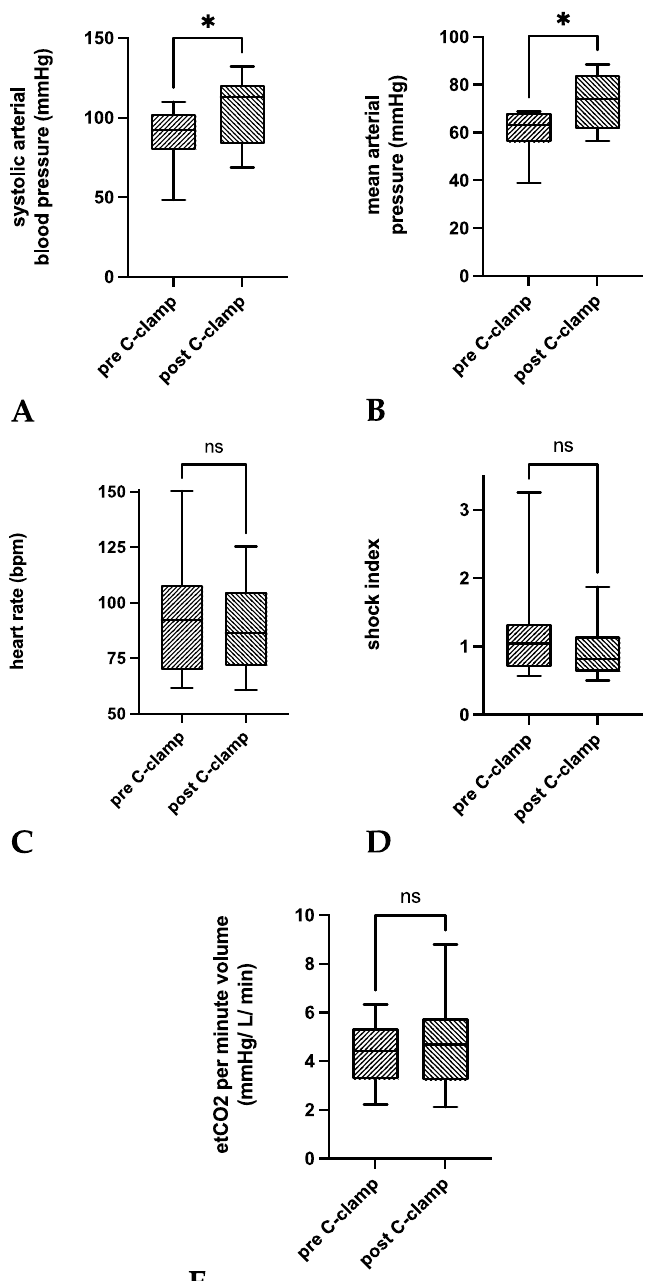
Figure 2. Box plots of the pairwise comparisons of means 30 min before (pre C-clamp) and after (after C-clamp) C-clamp application for ( A ) sABP, ( B ) MAP, ( C ) heart rate, ( D ) shock index, and ( E ) etCO 2 per minute volume. Paired comparisons of respective means revealed a significant mean increase of sABP (+14.9 mmHg; 95% CI 1.9–28; p = 0.0284) and MAP (+12.1 mmHg; 95% CI 2.1–23.5; p = 0.0157) after C-clamp application. Mean HR, SI, and etCO 2 per minute volume did not significantly differ before and after C-clamp application. Box—interquartile range; bar—median. * p < 0.05. A shorter time to C-clamp application was associated with a greater increase in the mean sABP ( p = 0.0253, r = -0.6149; Figure 3A), a greater decrease in HR ( p = 0.027, r = 0.6094; Figure 3B), and a greater decrease in SI ( p = 0.0012, r = 0.7929). Age, weight, admission GCS, initial lactate, initial hemoglobin, initial pH, ISS, and the estimated extent of blood loss were not significantly correlated with changes in vital